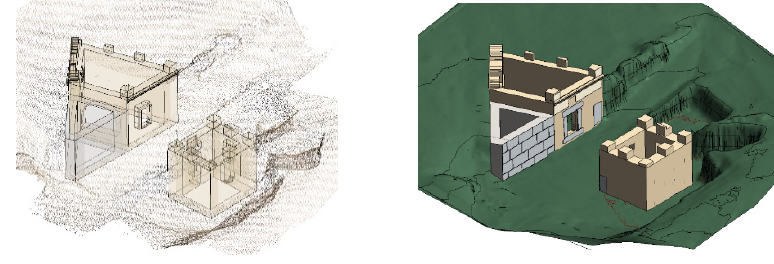
Figure 25. Different visualization styles of the HBIM model whereby one can obtain geometric data of heritage buildings.